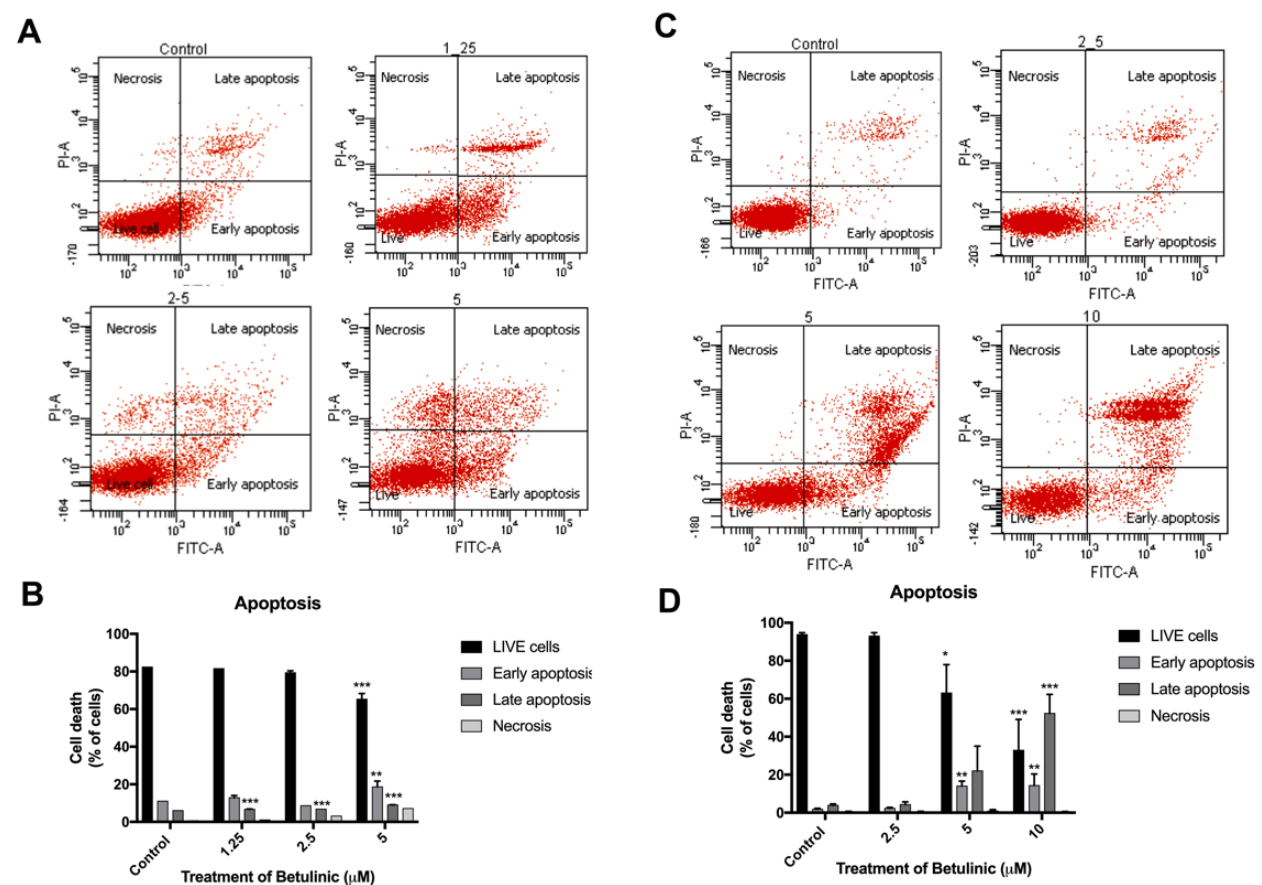
Figure 5. Annexin V-FITC/PI staining showing BA-induced apoptosis in HCT116 ( A,B ) and SW480 ( C,D ) human colorectal cancer cells at 24 h. Apoptotic cells are indicated by the red dots in upper and lower right quadrants of each diagram, whereby lower and upper panels represent early and late stages of apoptosis, respectively. Experiments were carried out in triplicate. One-way ANOVA and with Dunnett’s post hoc test were used to test statistical significance with * indicating p < 0.05, ** p < 0.01 and *** p < 0.001 vs. control group.